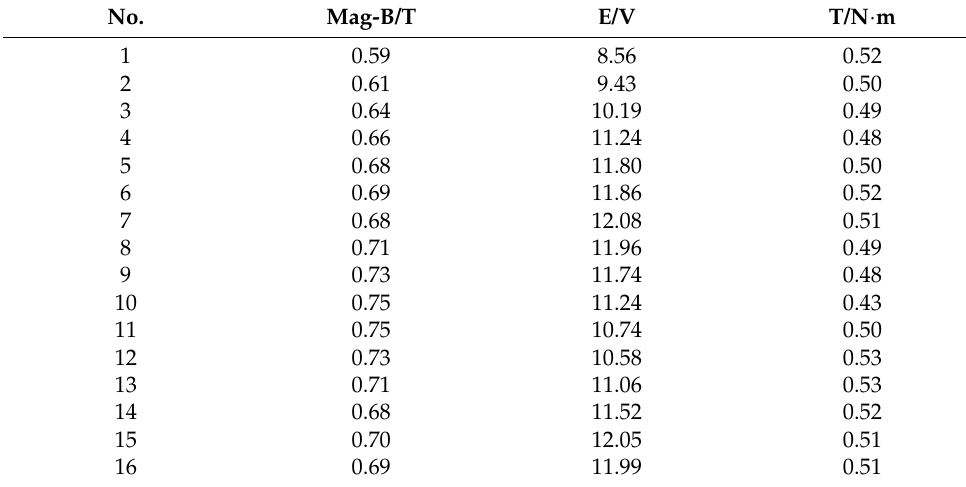
Table 5. Orthogonal experimental results.